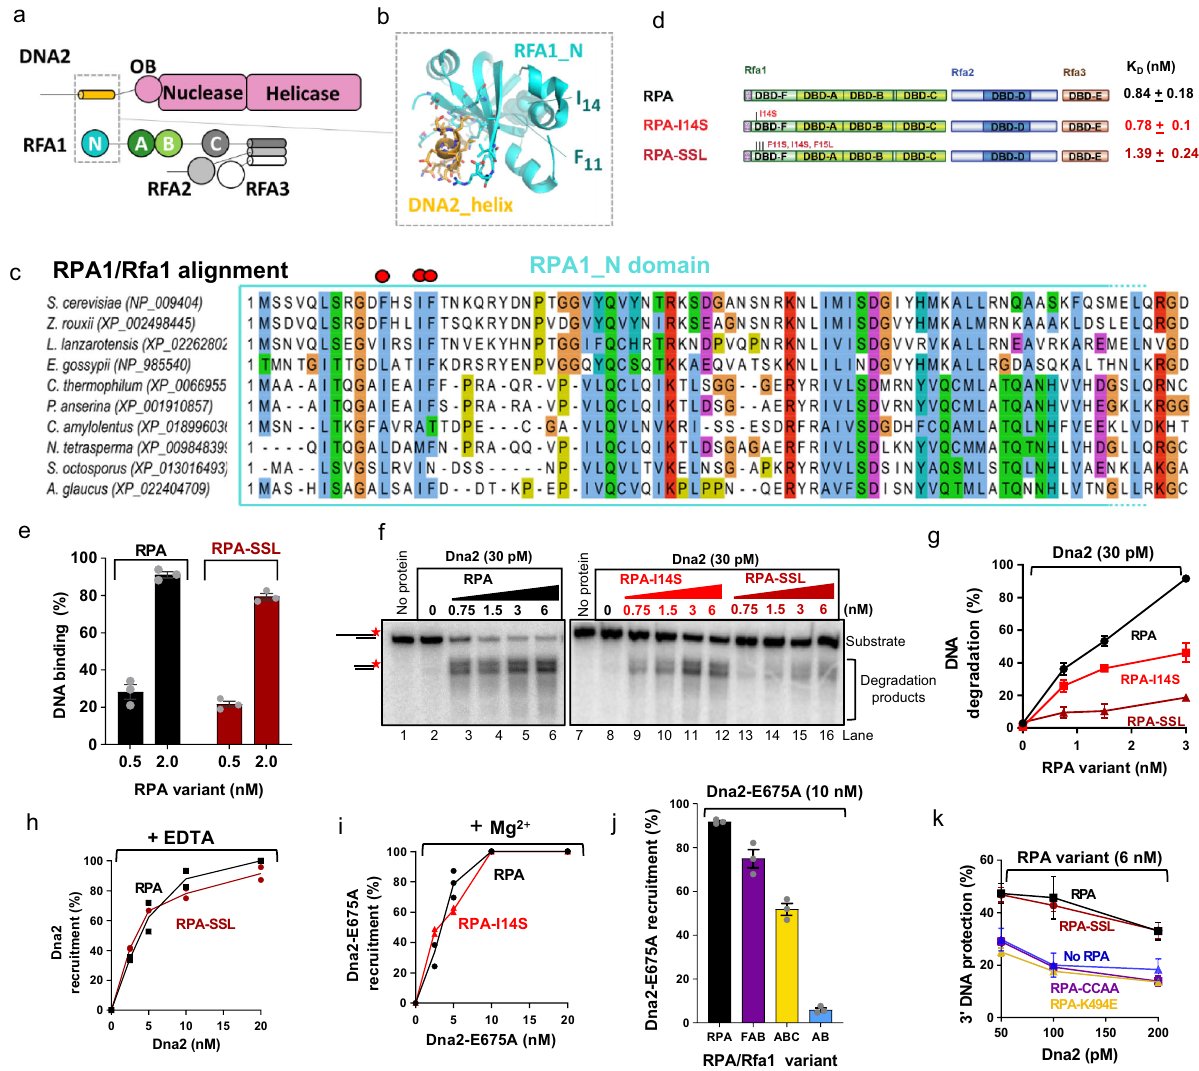
Fig. 4 Dna2 recruitment and nuclease stimulation by RPA are genetically separable. a A schematic representation of the domain organization in Dna2 and RPA. b A scheme of the interaction between the N-terminal domain of S. cerevisiae Rfa1 (DBD-F) and the predicted helix within the N-terminal part of Dna2 generated by comparative modeling using the structure of the orthologous human complex (PDB: 5EAY). Residues I14 and F11 mutated in this study are highlighted. c Multiple sequence alignment of RPA1/Rfa1 orthologs from various species focused on the N terminal region of RPA1, emphasizing the conserved positions located in the interface of the structural model of the complex between yeast Rfa1 and Dna2. d A schematic representation of the primary structures of RPA-SSL mutant. Wild type RPA and RPA-I14S are again shown as reference. K D, concentration of the respective RPA variant resulting in 50% binding to ssDNA (93 nt, 0.1 nM, in molecules,) such as shown in Supplementary Fig. 4b; Error, SEM; n = 3. e Quantitation of ssDNA (93 nt, 0.1 nM, in molecules) binding by wild type RPA and RPA-SSL mutant in assays such as shown in Supplementary Figs. 3c and 4b. RPA is replotted as in Fig. 3b for reference. Error bars, SEM; n = 3. f Representative nuclease assays using Dna2 and 5 ′ -overhanged DNA substrate (45 nt ssDNA, 48 bp dsDNA, 1 nM, in nucleotides) performed as in Fig. 1d, but with 100 mM NaCl. The red asterisk indicates the position of the radioactive label. g Quanti fi cation of nuclease assays such as shown in panel f . Error bars, SEM; n = 3. h Quanti fi cation of DNA binding assays such as shown in Supplementary Fig. 4g. Wild type Dna2 was bound to 5 ′ -overhanged DNA substrate (45 nt ssDNA, 48 bp dsDNA, 1 nM, in molecules) pre-coated with either wild type RPA or RPA-SSL in the presence of 3 mM EDTA and 150 mM NaCl. Bars indicate range; n = 2. i Quanti fi cation of experiments as in panel h , but with Dna2-E675A in the presence of 5 mM Mg 2 + and 150 mM NaCl. RPA is replotted as in Fig. 2a for reference. Bars indicate range; n = 2. j Quanti fi cation of assays such as shown in Supplementary Fig. 4h showing Dna2-E675A binding to 5 ′ -overhanged DNA substrate (30 nt ssDNA, 31 bp dsDNA, 1 nM, in molecules) pre-coated with RPA, Rfa1-FAB, Rfa1-ABC or Rfa1-AB fragments in the presence of 5 mM Mg 2 + and 150 mM NaCl. Error bars, SEM; n = 3. k Quanti fi cation of assays such as shown Supplementary Fig. 4i. The respective RPA variant was tested for capacity to protect 3 ′ -overhanged DNA substrate (45 nt ssDNA, 48 bp dsDNA, 1 nM, in molecules) from Dna2 degradation with 100 mM NaCl. Error bars, SEM; n =